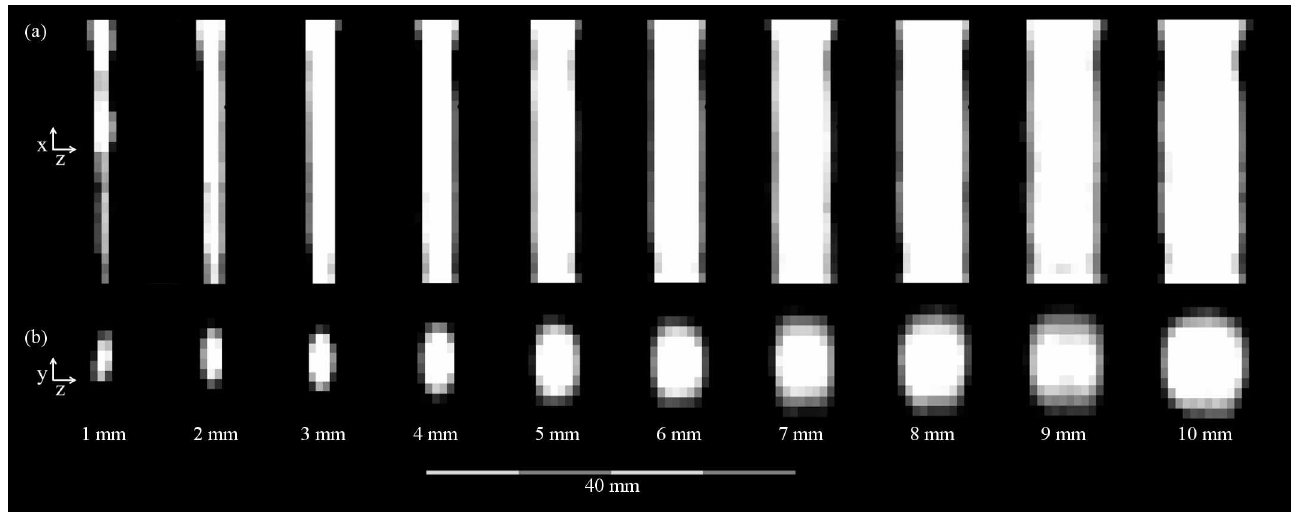
Fig 2. MPI-Images of the referencephantoms. Sagittal (a) and axial (b) slices extracted from reconstructed 3D image data of the reference phantoms. Note the anisotropy of the axial images due to the different gradientfield strengths, leadingto an oval appearance of the phantomswhich is the more pronounced, the smaller the lumen is.